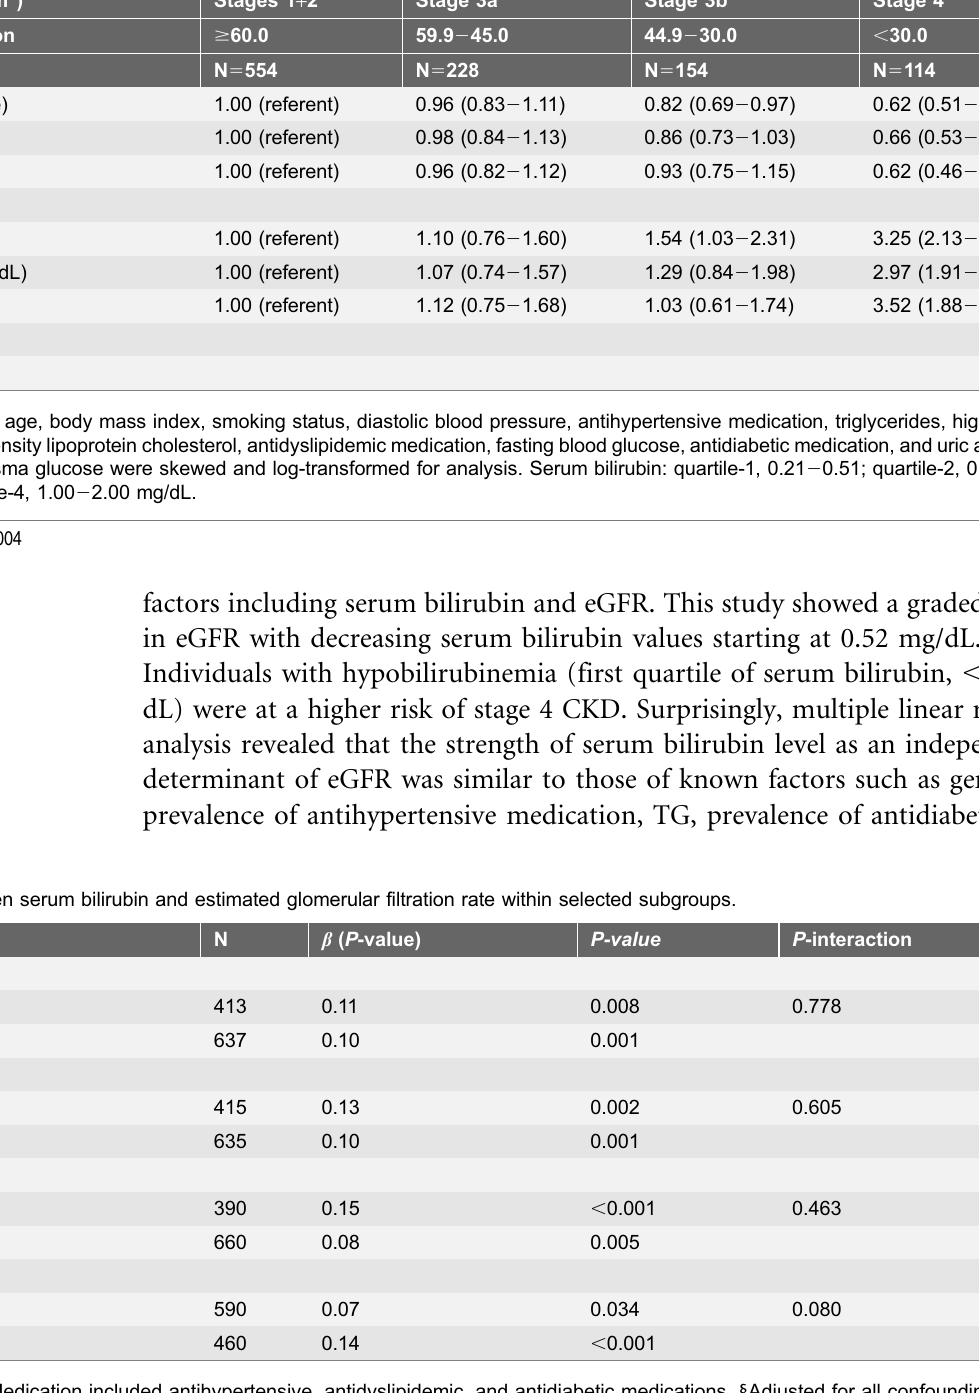
Table 4. Odds ratio of renal dysfunction for decrease in serum bilirubin and hypobilirubinemia. Odds ratio (95% confidence interval)